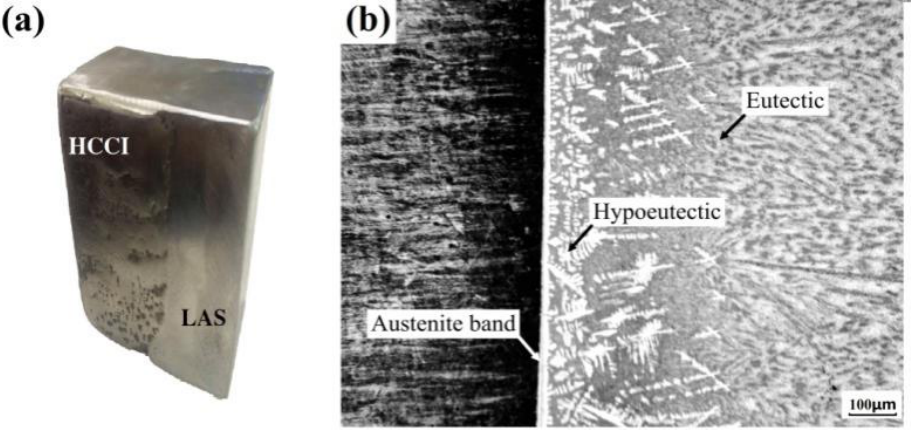
Figure 3. Interface of the HCCI hardfacing layer ( a ) The macro-profile, ( b ) The micro-structure.